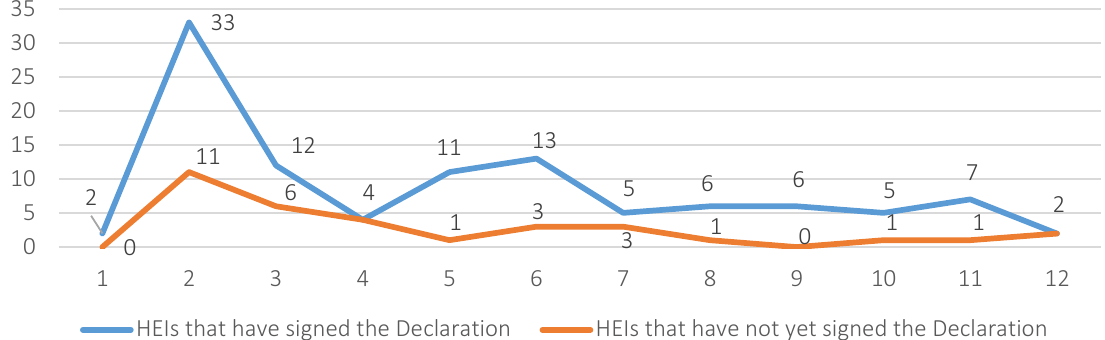
Figure 1. Number of SR practices under the items of the Declaration of HEIs’